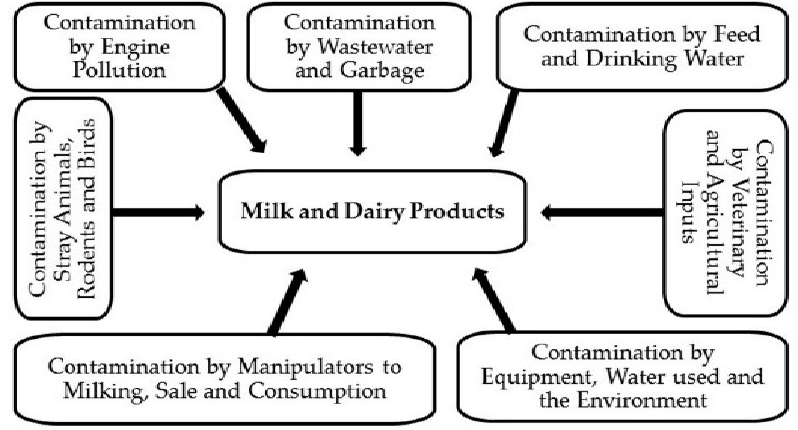
Figure 8. Source of the contamination of milk and dairy products.